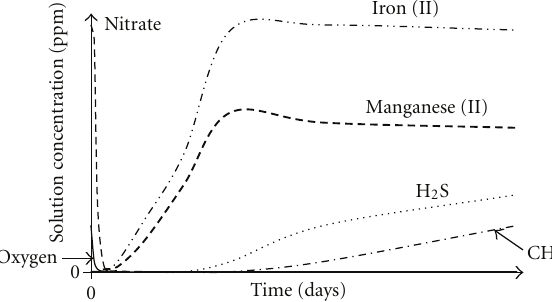
Figure 1: Typical temporal pattern for sequential reduction of electron acceptors assuming soil is inundated with water on day